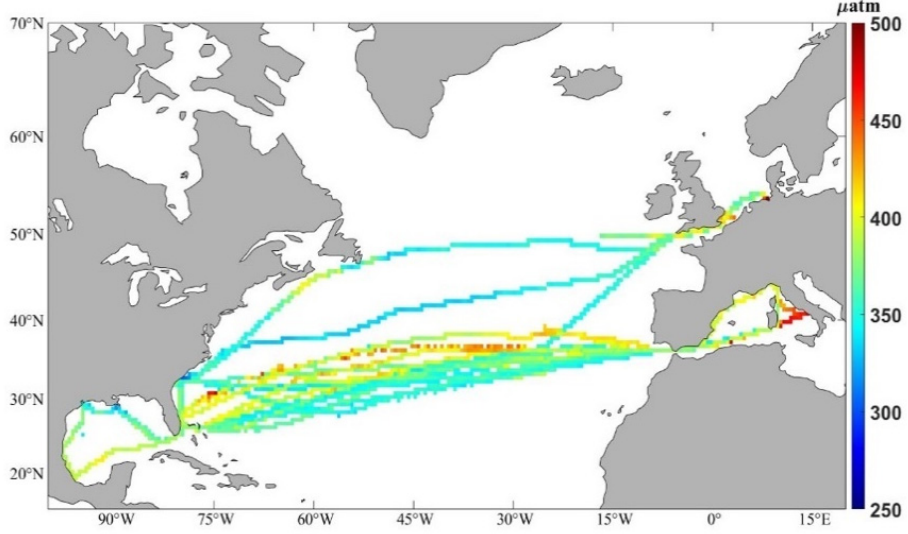
Figure 1. Sea surface pCO 2 from 20 cruises in the North Atlantic from 2010 to 2013. In particular, Chla, Adg and Kd can reflect the effects of biological activities and phys- ical mixing of water masses; while SST and MLD are able to capture the thermodynamic effects and monitor the freshwater characteristics of multiple river inputs and thermody- namic effects, respectively. Therefore, they are selected for further model building purposes in this study. The sources of these data were listed in Table 1. Table 1. Data source about remote sensing product in the